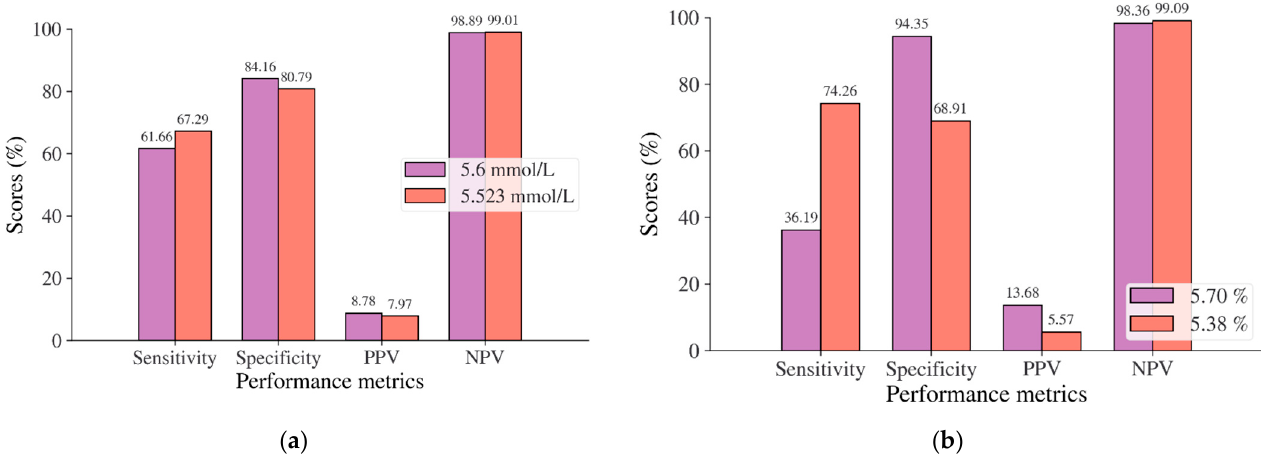
Figure 3. ROC curve for FPG values as a screening test on the Chinese diabetes dataset. FPG was used as the gold standard; the straight line represents the reference line.